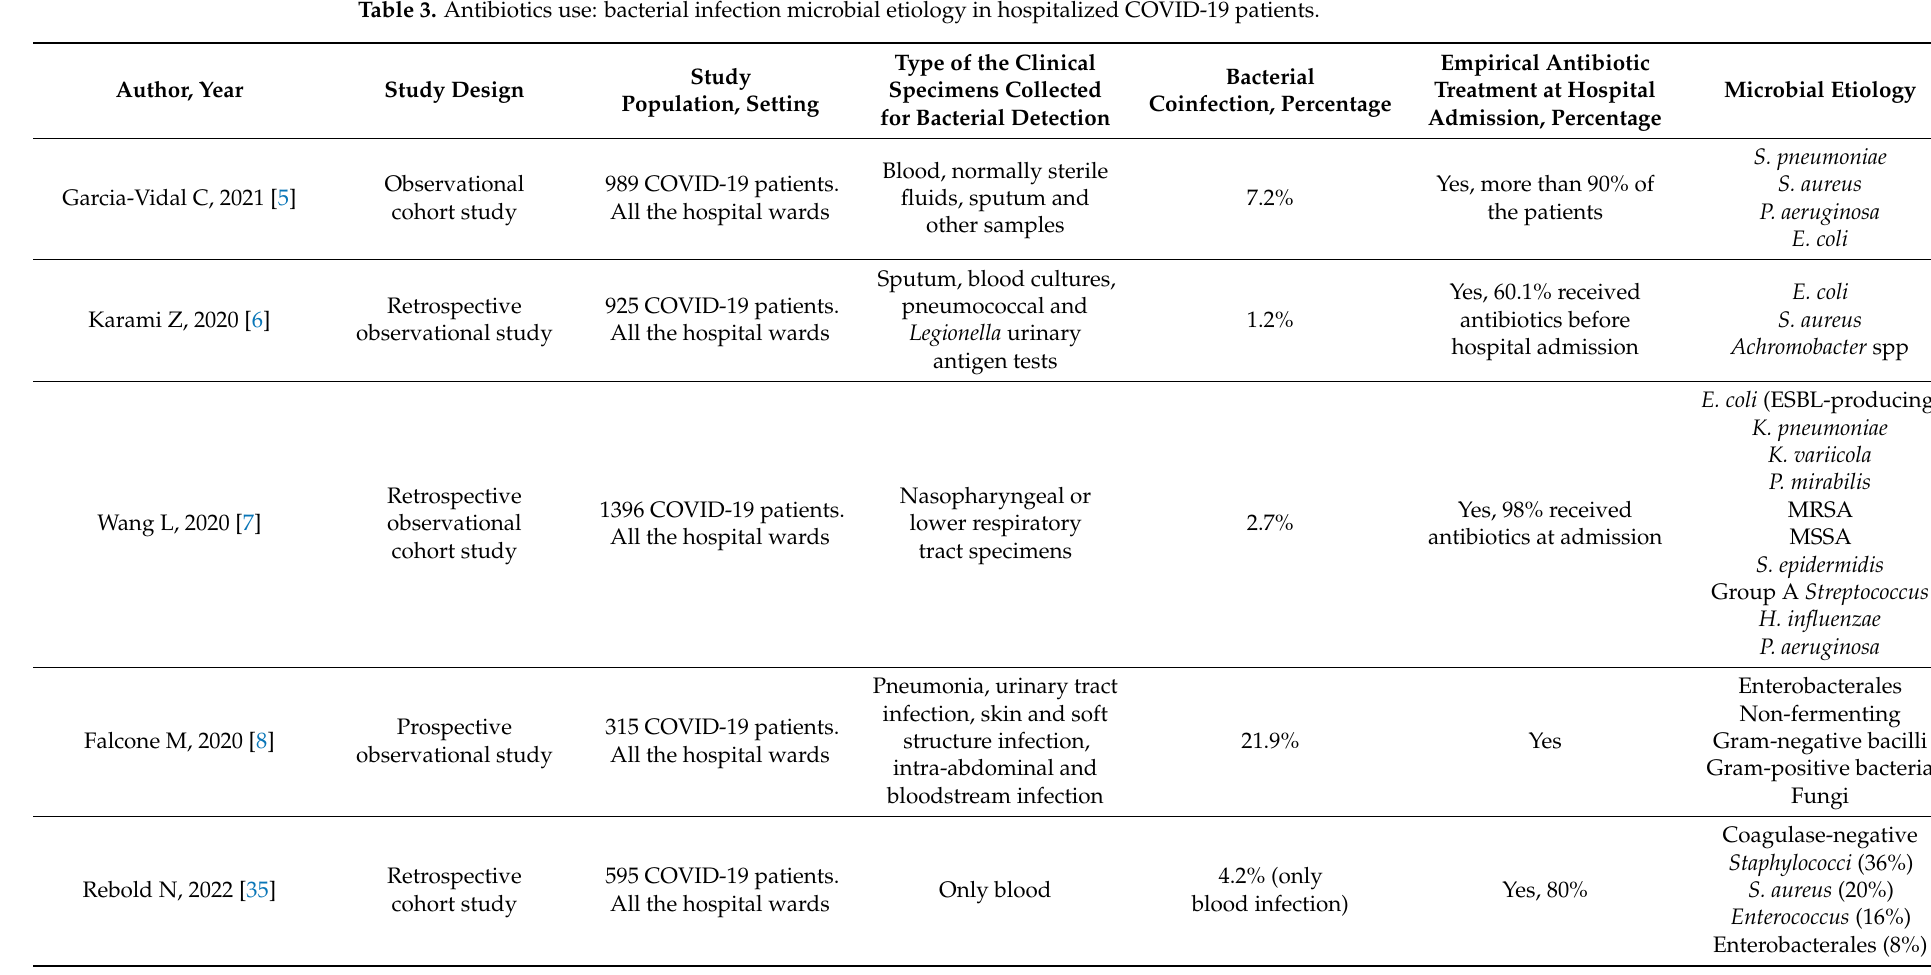
Table 3. Antibiotics use: bacterial infection microbial etiology in hospitalized COVID-19